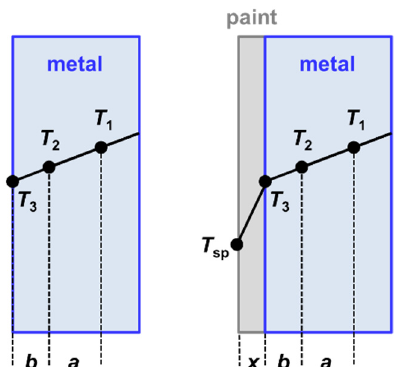
Figure 9. Determination of the surface temperatures of two different specimens by extrapolation, namely a metal (shown on the left) and a paint, which is applied on a metal substrate (shown on the right). T 1 and T 2 are the temperatures, which are detected by two radiation thermometers. T 3 and T sp are calculated subsequently.